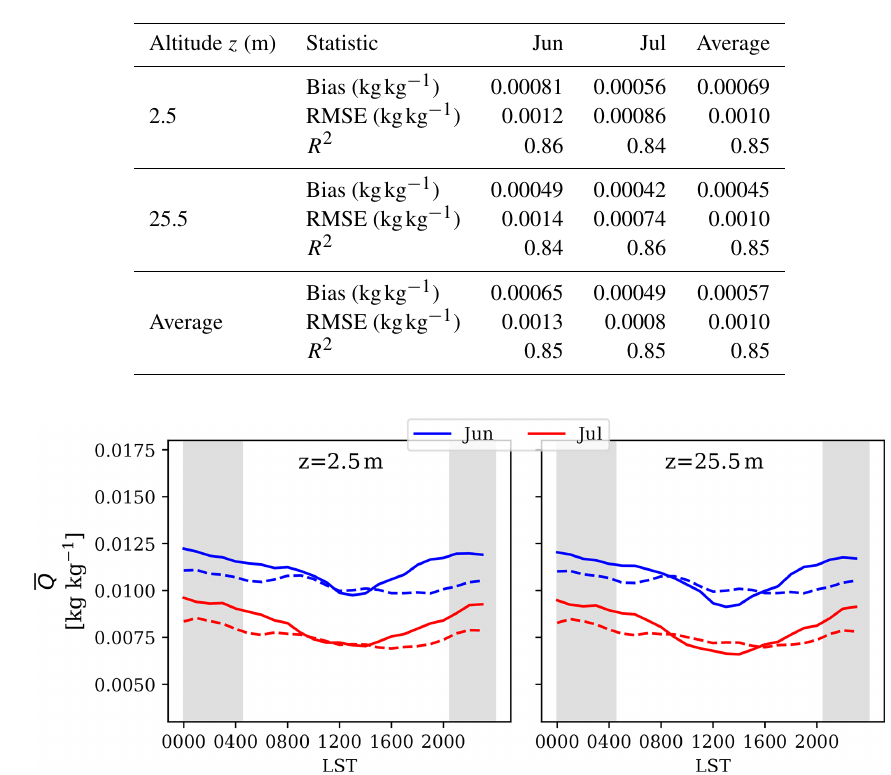
Table 4. Bias (kgkg − 1 ), RMSE (kgkg − 1 ), and R 2 (–) for VCWG predictions of specific humidity against the BUBBLE observations for different altitudes and months.